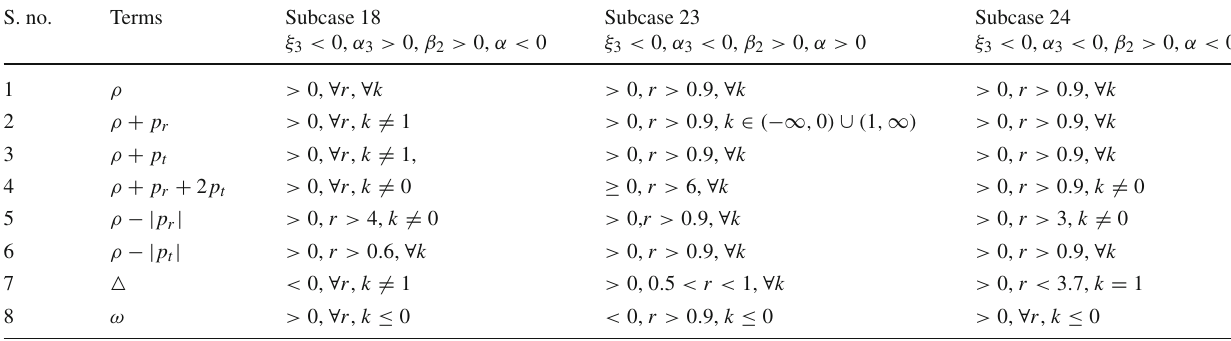
Table 11 Results for Form III: ρ = α 3 R 2 + β 2 R (cid:2) e ξ 3 R S.